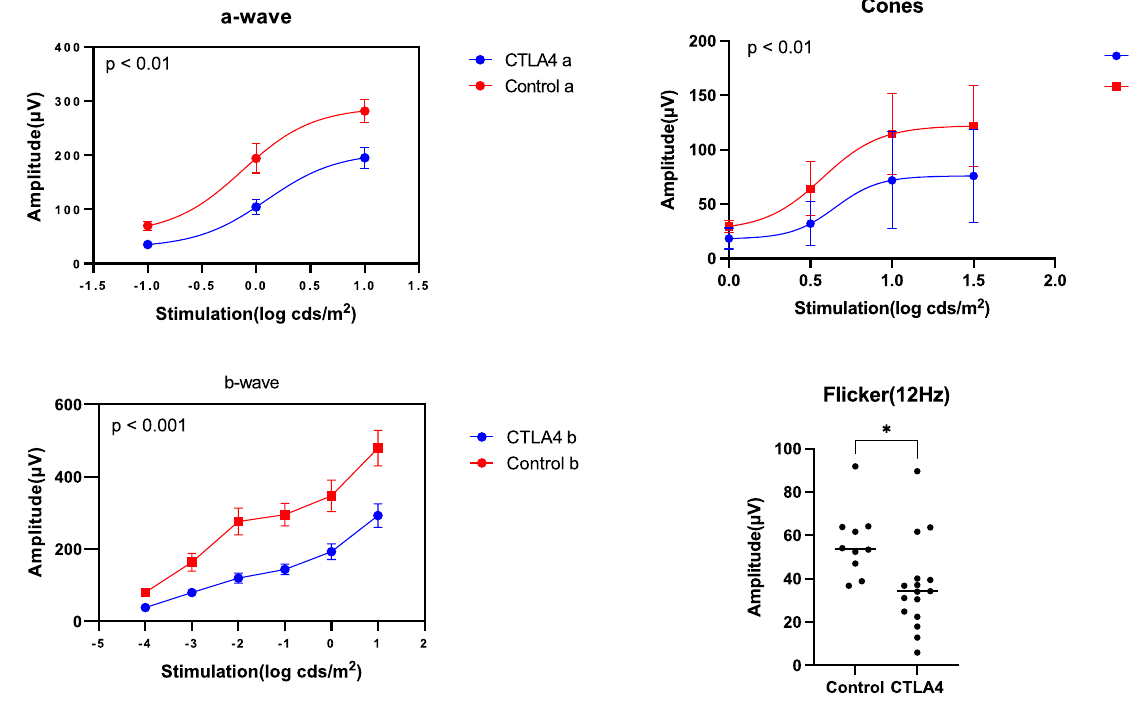
Figure 10. Mean responses for the a-wave, b-wave, cones, and 12-Hz flicker tests for control and treated eyes (n = 5 in each group). In the analysis of whole waves, the mean amplitudes were significantly lower for treated eyes than for control eyes ( P < 0.01, P < 0.001, and P < 0.01,